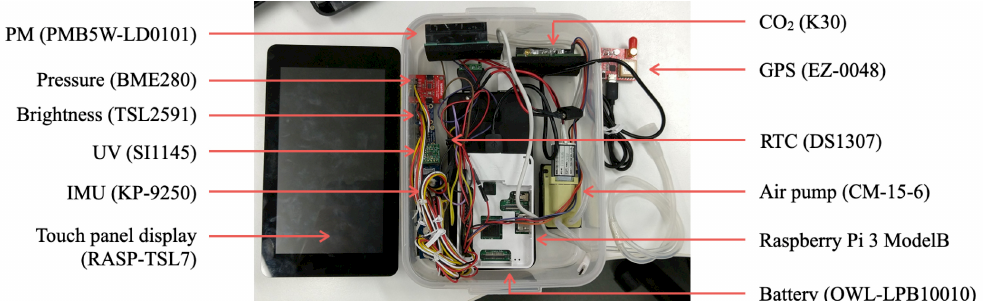
Figure 3. Assembled MSS and part assignment.